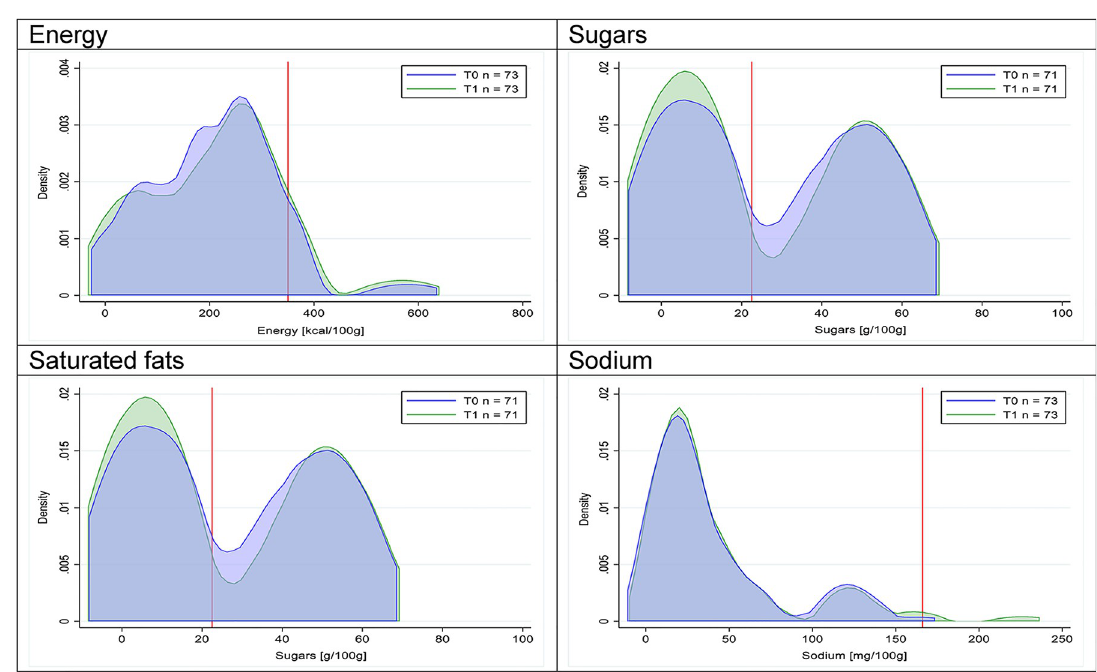
Fig 25. Density curves for the amount of energy and nutrients of concern in sweet spreads, longitudinal subsample. The blue line represents the distribution in T0 (preimplementation), the green line represents the distribution in T1 (postimplementation), and the red line represents the cutoff for the amount of energy or nutrients of concern.